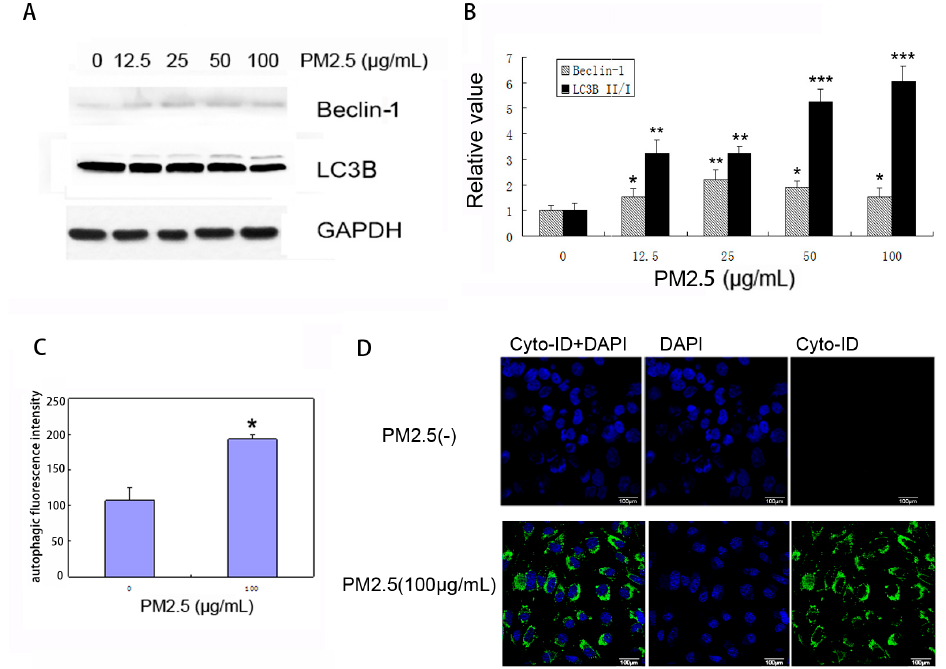
Figure 3. PM2.5 exposure induces autophagy in MAECs. ( A ) Cells were exposed to 0, 12.5, 25, 50, or 100 µg/mL PM2.5 for 24 h, and the expression of LC3B, Beclin-1, and GAPDH were examined ( n = 3); ( B ) Bands quantified for Western blot analysis. * p < 0.05; ** p < 0.01; *** p < 0.001; ( C ) MAECs were treated with PM2.5 (100 µ g/mL) for 24 h and stained with Cyto-ID reagent, followed by collection and flow cytometric analysis to quantitatively measure autophagic fluorescence intensity ( n = 3). * p < 0.05. ( D ) MAECs were exposed to PM2.5 as described in ( C ), and autophagy was examined by confocal microscopy after cell staining. Scale bar = 100 µ